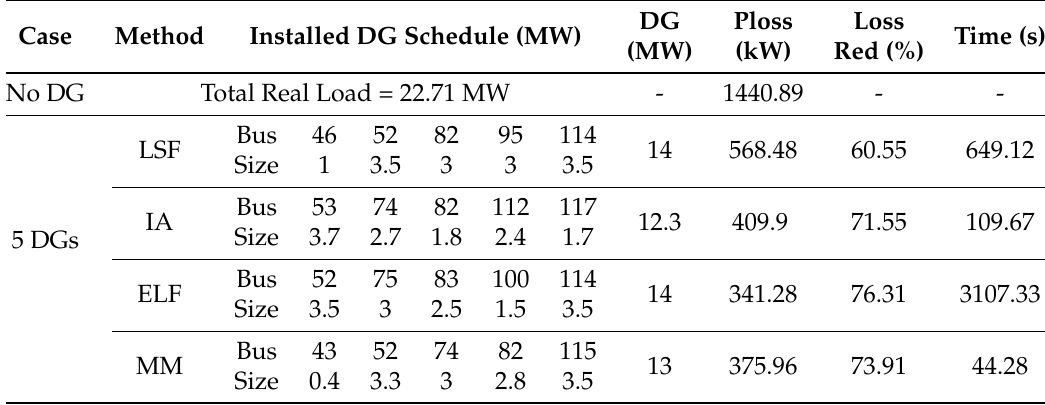
Table 4. DG placement by different methods for IEEE 119 node system at 0.95 power